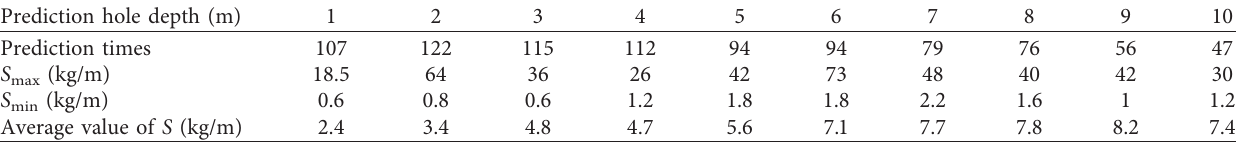
Table 5: Prediction cycle drilling chip amount index S with changing hole depth.